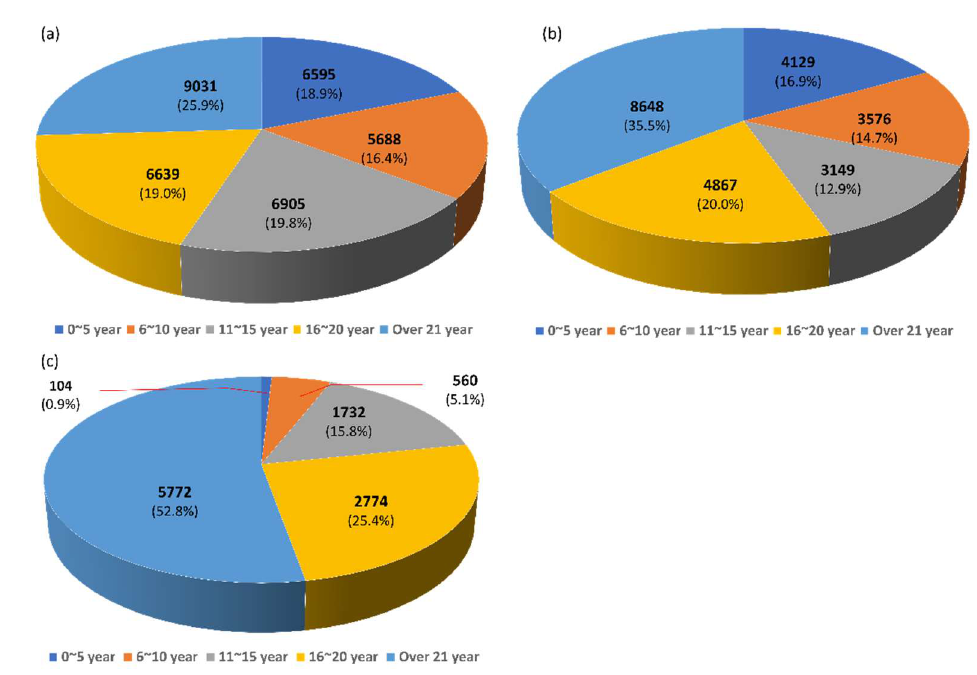
Figure 15. The proportion of ships by tonnage in different engine types: ( a ) gasoline engine; ( b ) diesel engine; ( c ) diesel engine vehicle.